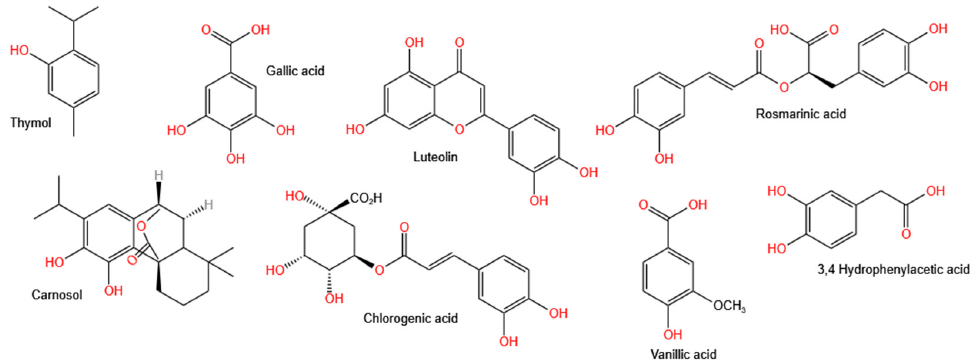
Figure 2. Polyphenolic compounds found in some Lamiaceae plants.